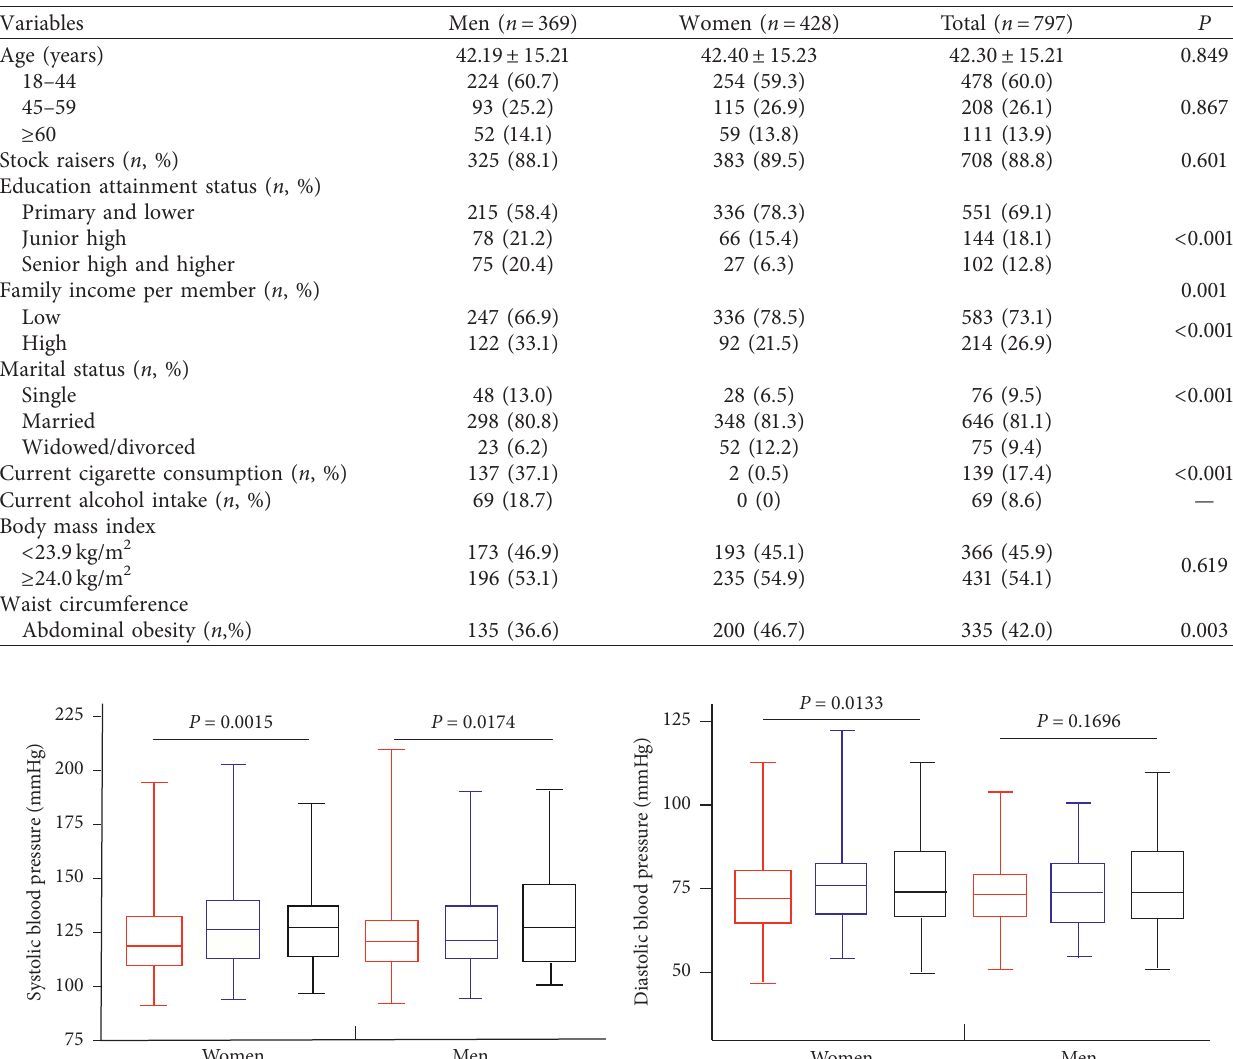
Table 1: Baseline characteristics of the study population by sex.